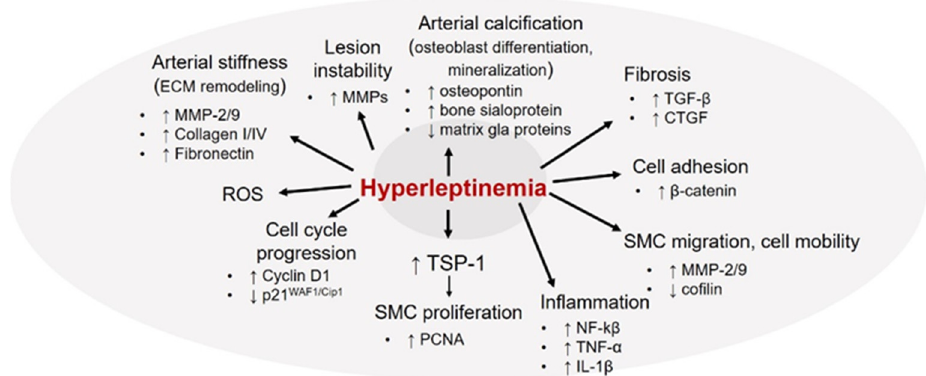
Figure 4. Hyperleptinemia-induced SMC activation and phenotypic changes triggering atheroscle- rosis. MMP: matrix metalloproteinase; TGF- β : transforming growth factor- β ; ECM: extracellular matrix; TSP-1: thrombospondin-1; ROS: reactive oxygen species; CTGF: connective tissue growth factor. Please see text for additional details.